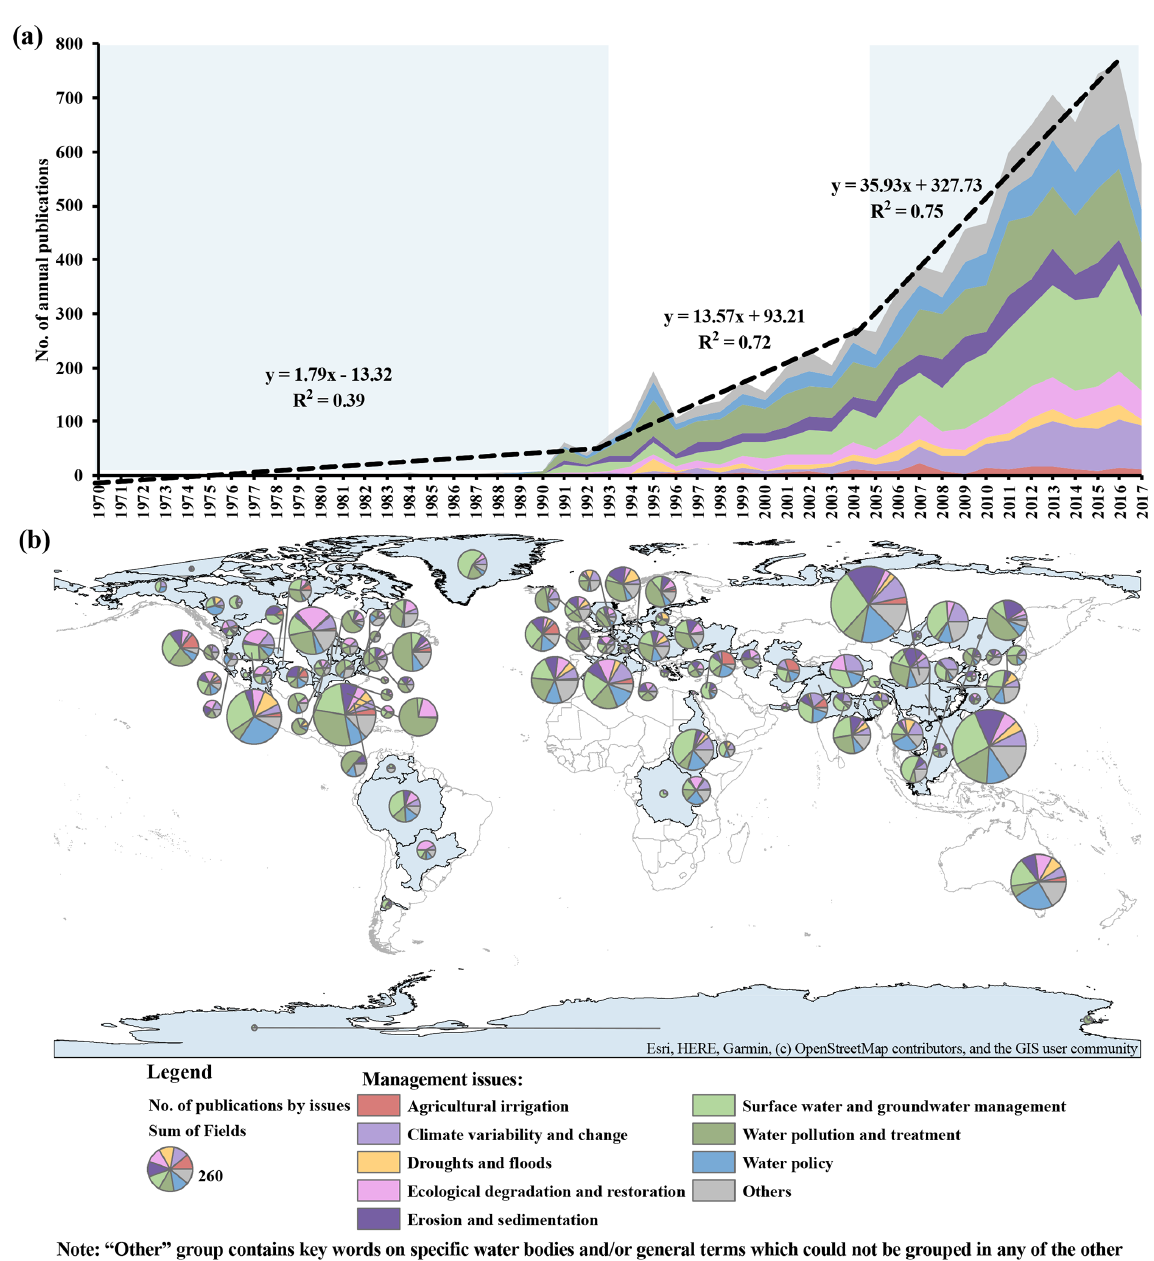
Figure 3. (a) The temporal development of annual publications on water resources, decomposed by the management issues. (b) The spatial distribution of total publications on water resources, decomposed by the management